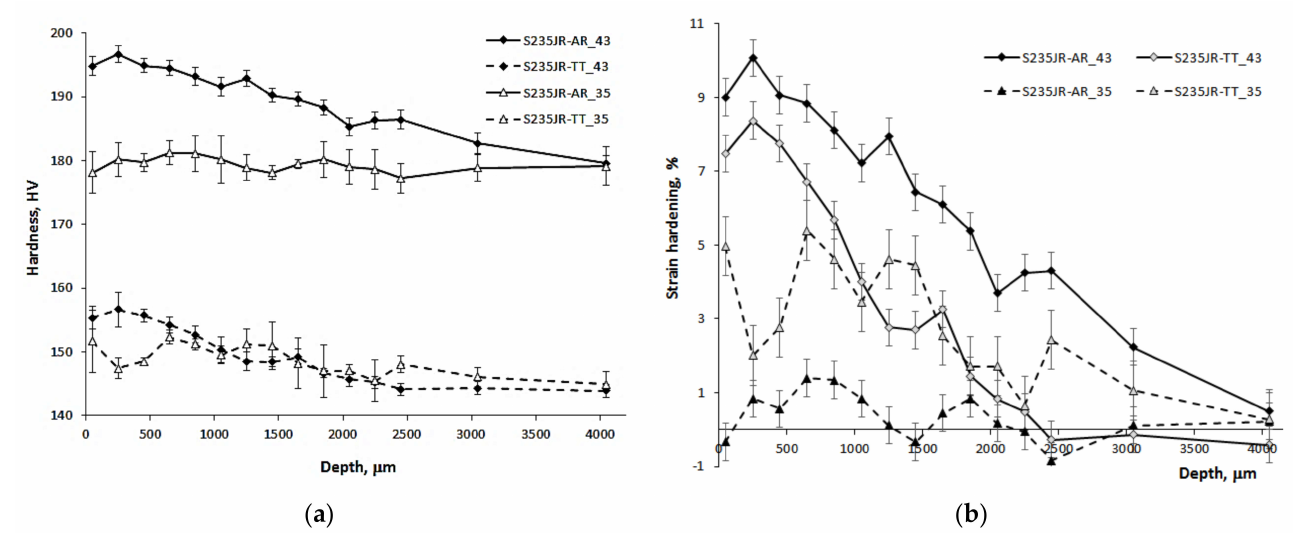
Figure 10. Hardness ( a ) and strain hardening effect ( b ) along the specimen depth caused by cavitation.